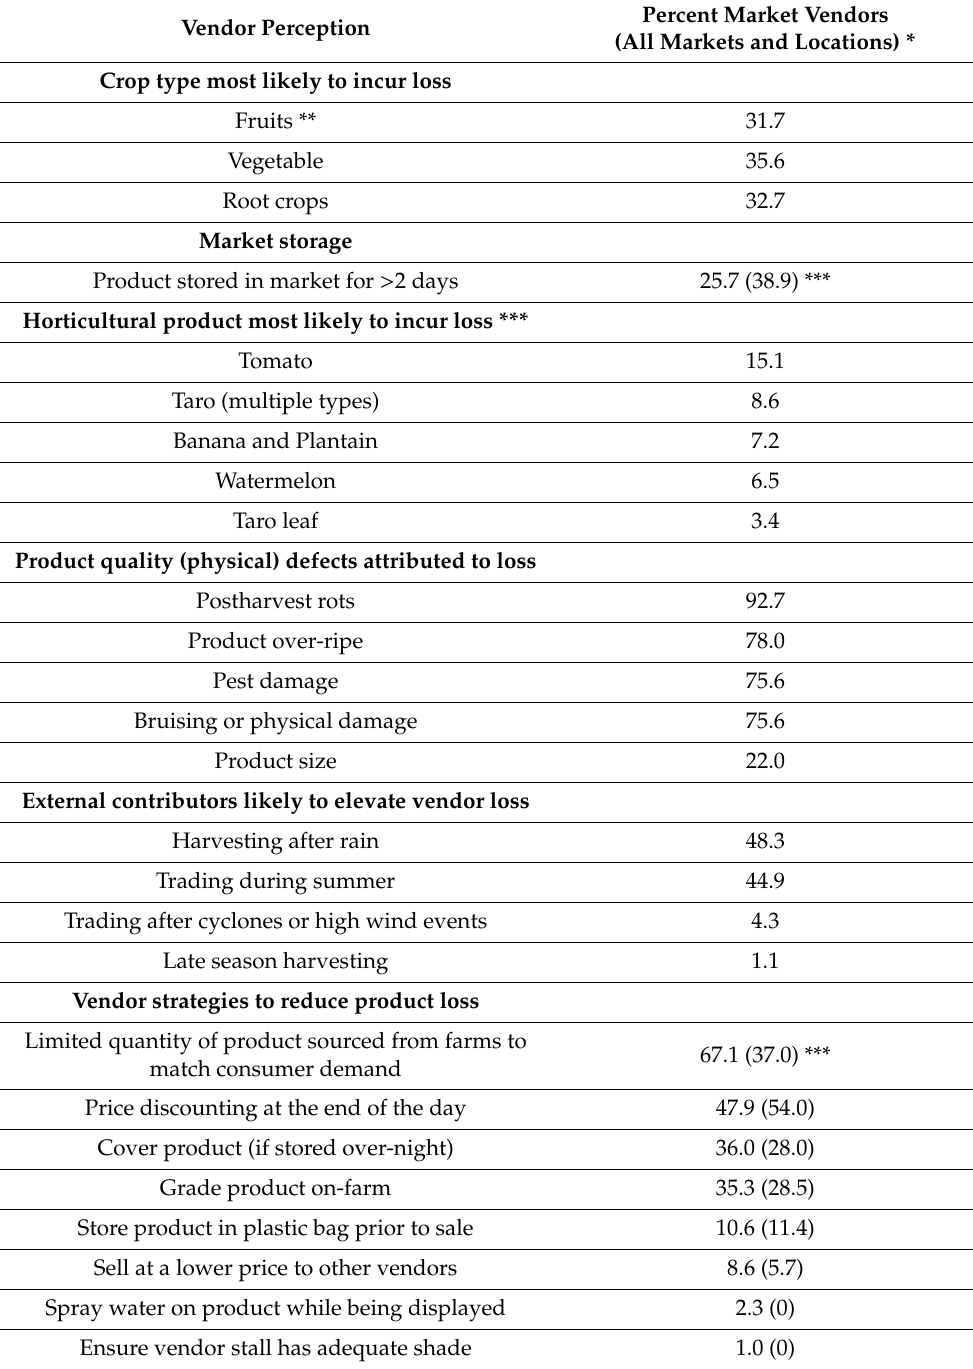
Table 4. Crop type, product quality defects, and external factors attributed to postharvest loss, based on percent of market vendor